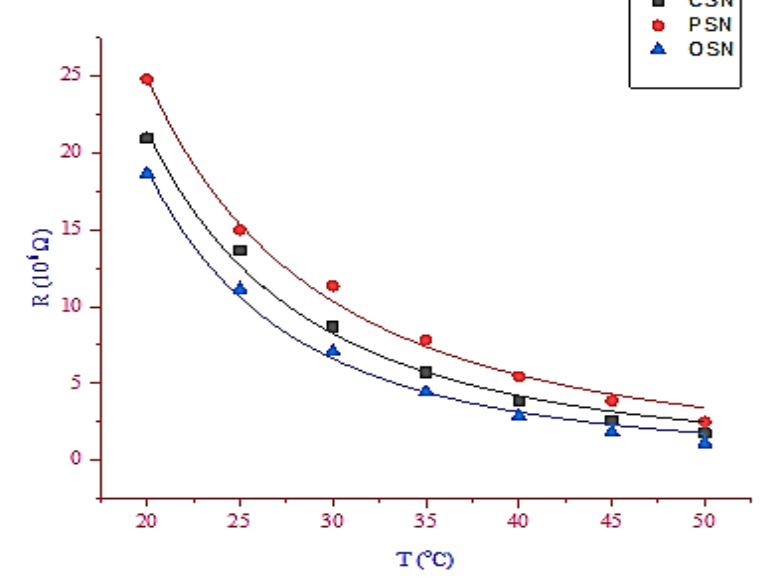
Figure 4. Variation of samples’ electrical resistance depending on temperature.